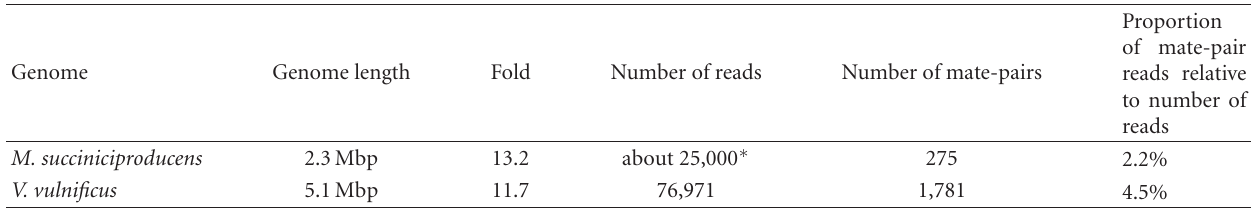
Table 1: Mate-pair information in real test datasets. The proportion of mate-pair reads for V. vulnificus is about double that for M. succiniciproducens.